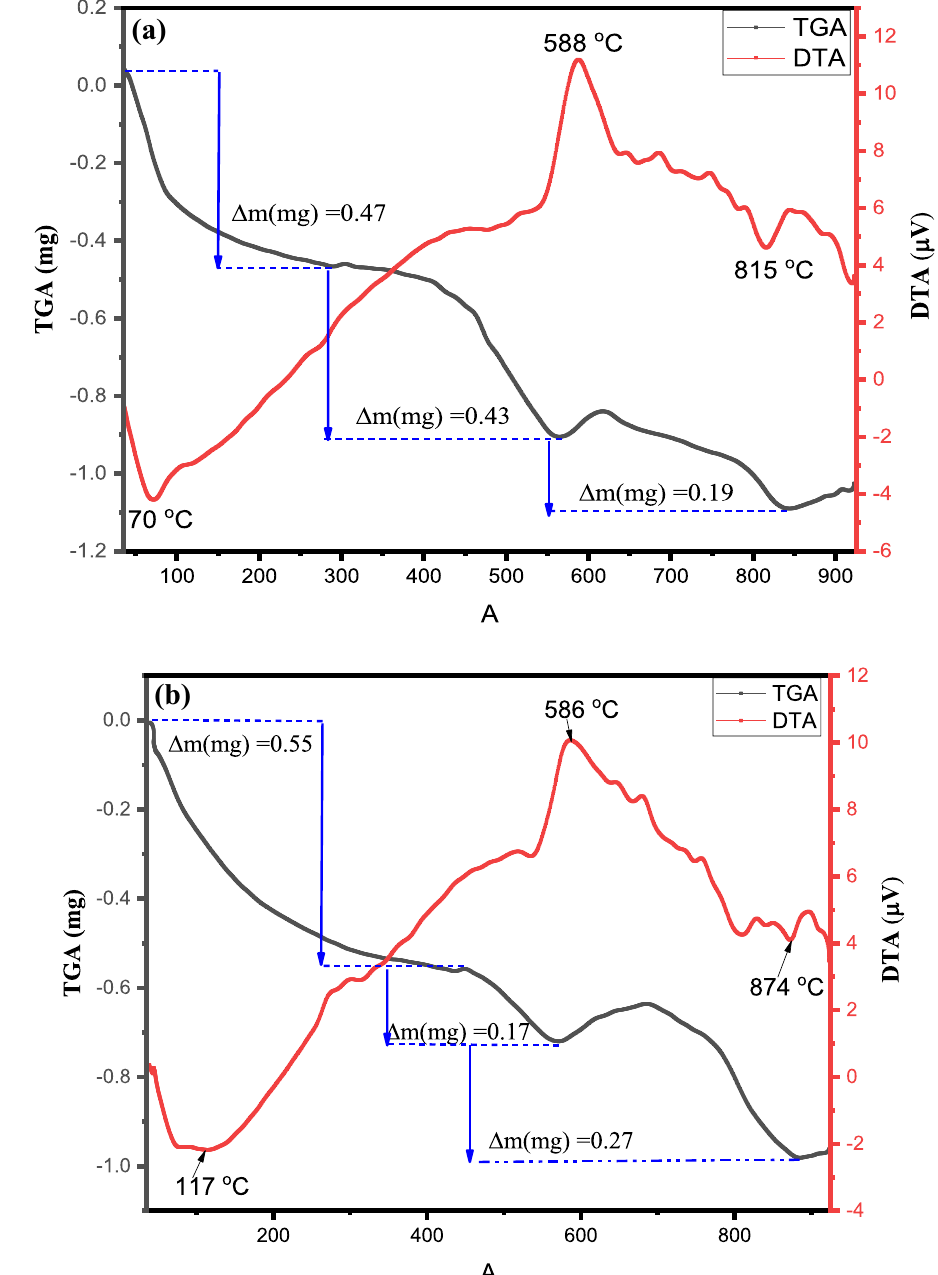
Fig. 10 TGA/DTA illustration of a MnO NPs, and b Ni-doped 2 MnO (0.125 M) 2